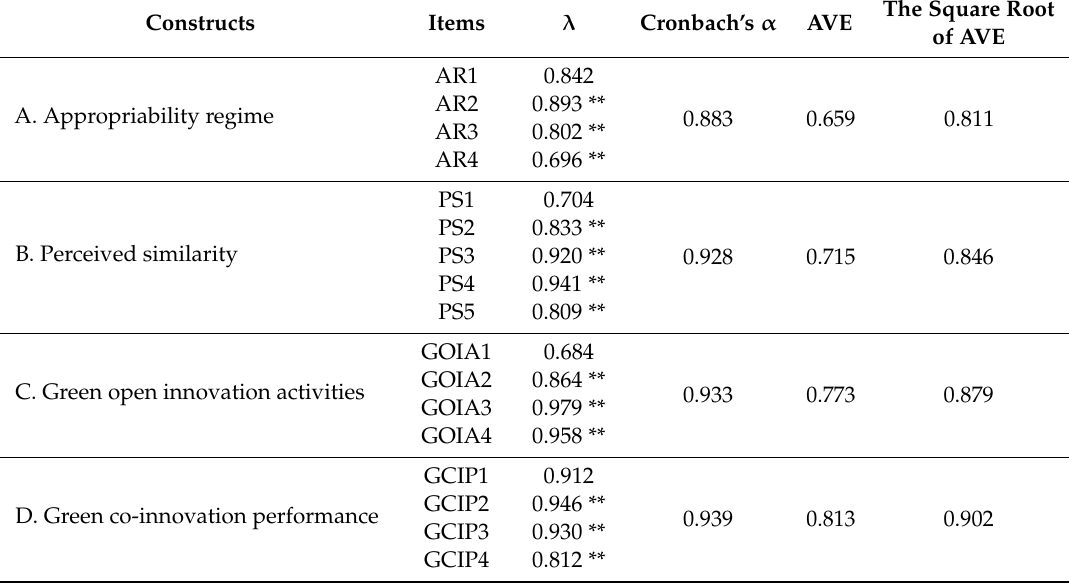
Table 5. Loadings ( λ ) of items and Cronbach’s α coe ffi cients and average variance extracted (AVE) of